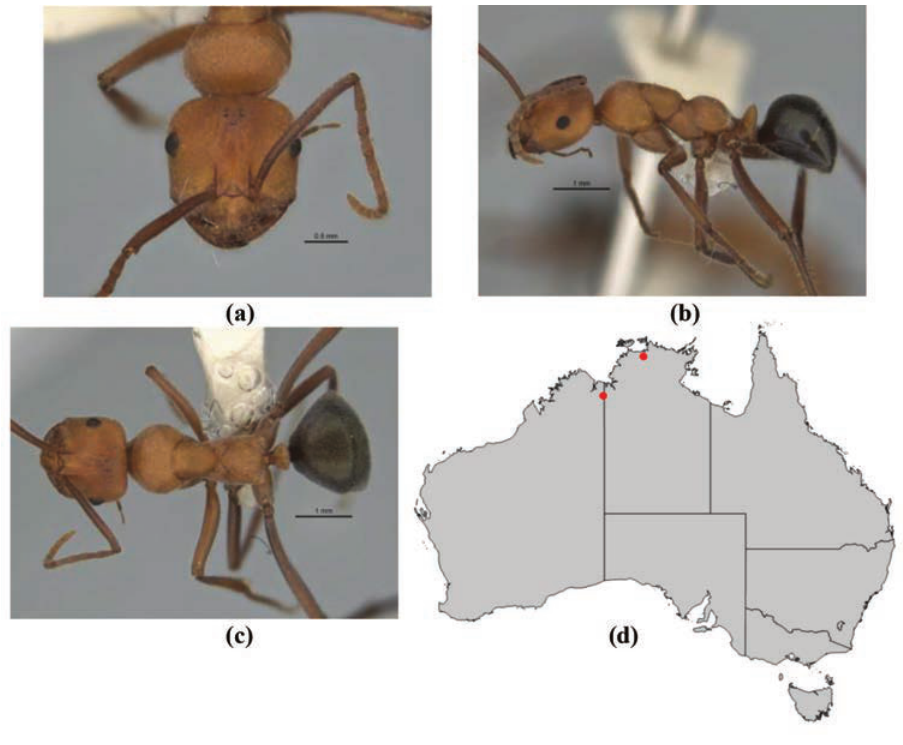
Figure 20. Melophorus sulconotus sp. n.: minor worker holotype (ANIC32-900071–middle ant) frons ( a ), profile ( b ) and dorsum ( c ); distribution map for the species ( d ). Low resolution scale bars: 1 mm ( b, c ); 0.5 mm ( a